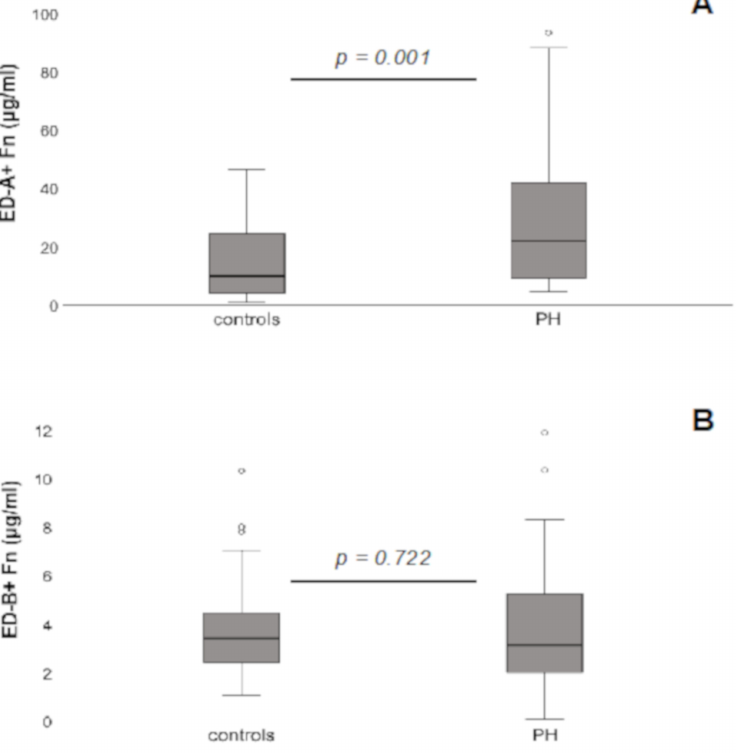
Figure 1. Increased serum levels of ED-A + Fn ( A ) but not ED-B + Fn ( B ) in patients with pulmonary hypertension (PH) compared to healthy controls. The box plots indicate the median (line inside the box), 25th and 75th percentile (lower and upper boundary of the box), 10th and 90th percentile (whiskers outside the box), as well as outlier values (dots). Fn =